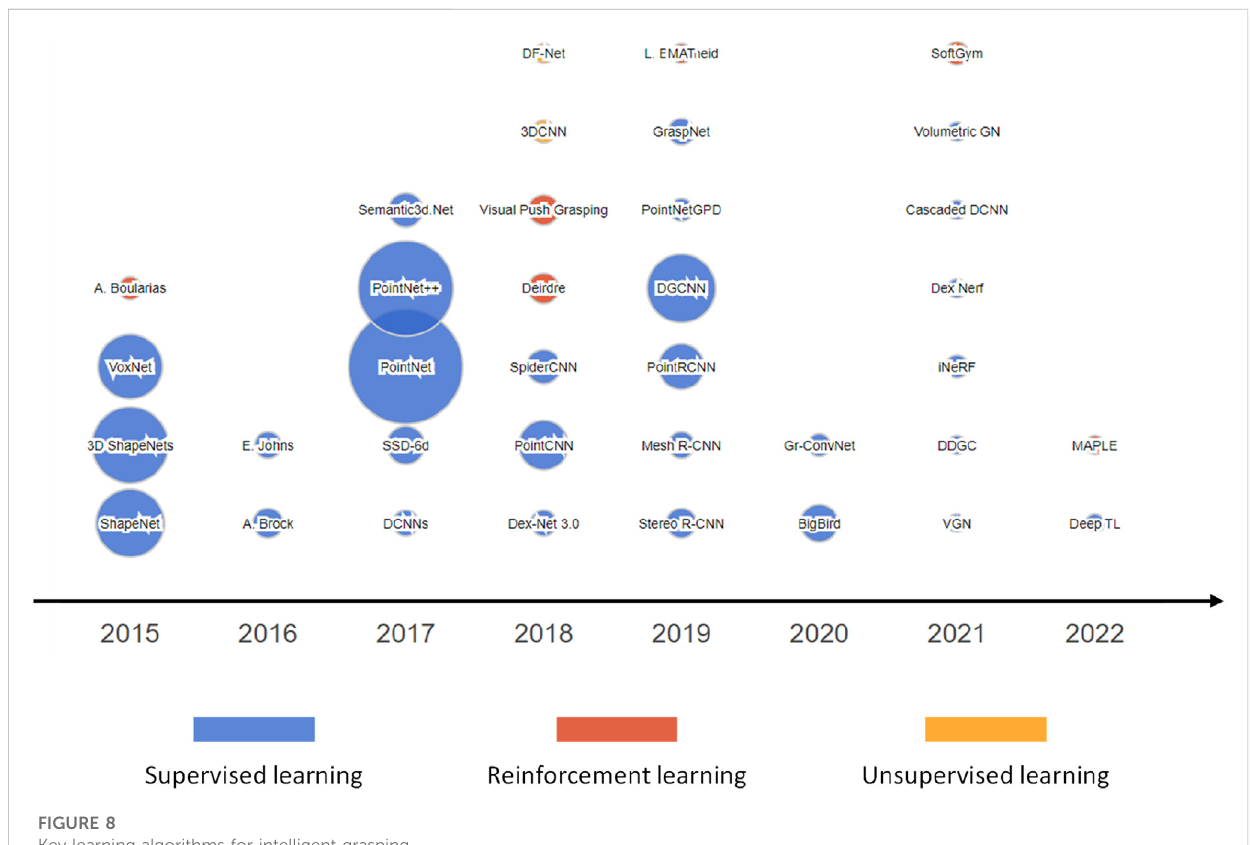
FIGURE 8 Key learning algorithms for intelligent